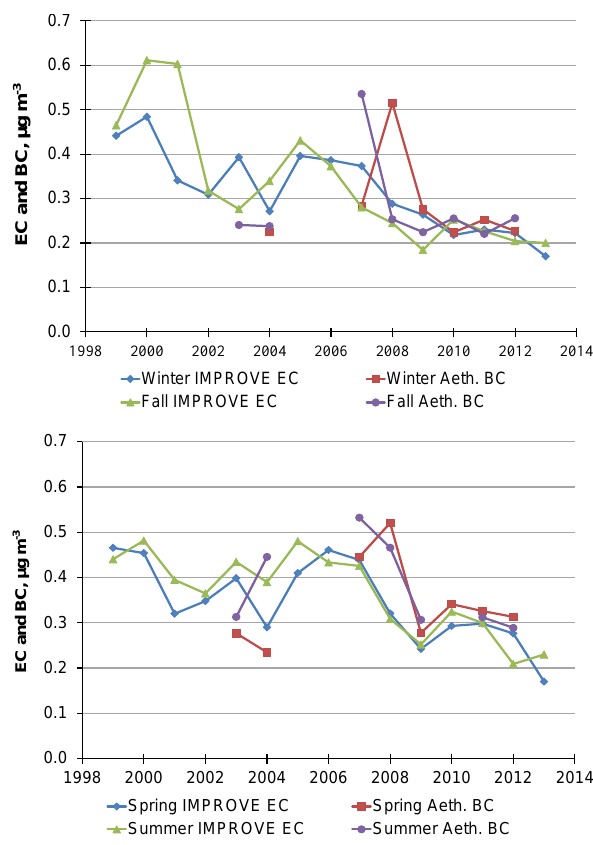
Figure 11. Trends in seasonal PM 2 . 5 EC and BC mass at Look